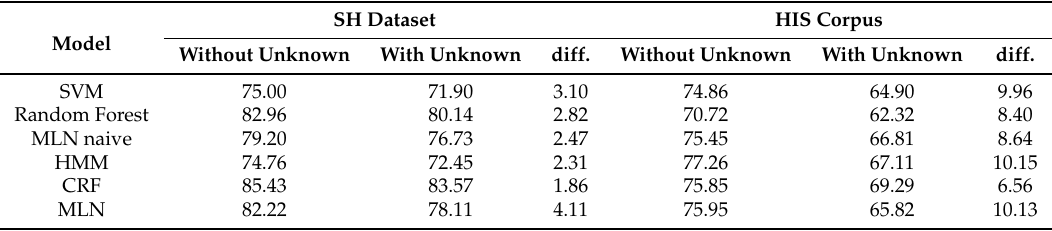
Table 1. Overall accuracy (%) results on the two datasets with and without the Unknown class. Table 3 of [19]. the (diff.) column represent the different between both conditions (with and without unknown